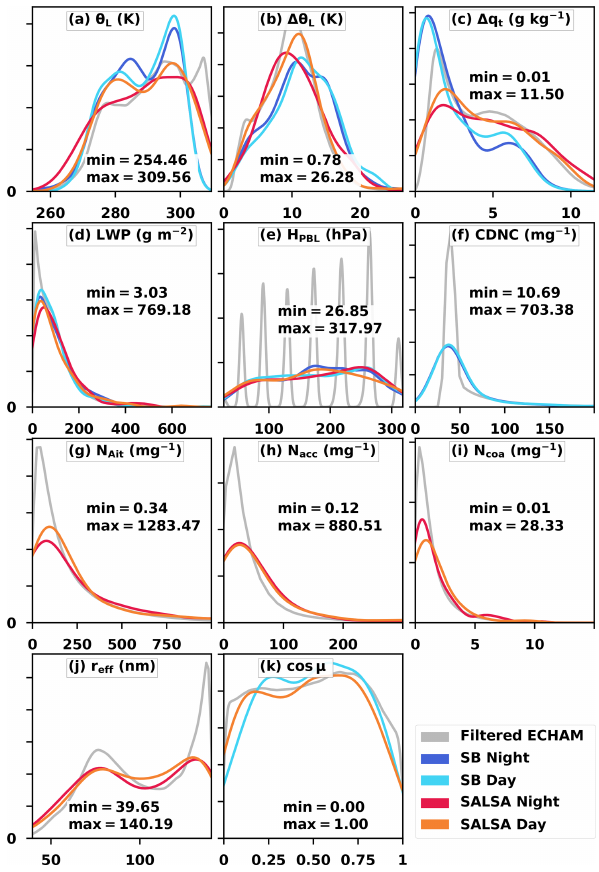
Figure 2. Filtered ECHAM-HAMMOZ data and kernel-density- estimated (KDE) LES input variable probability density functions (PDFs). The highest values in panels (f–i) are not shown as the den- sity is close to zero. Min and max values are extreme values of all LES sets (i.e. not ECHAM-HAMMOZ values).